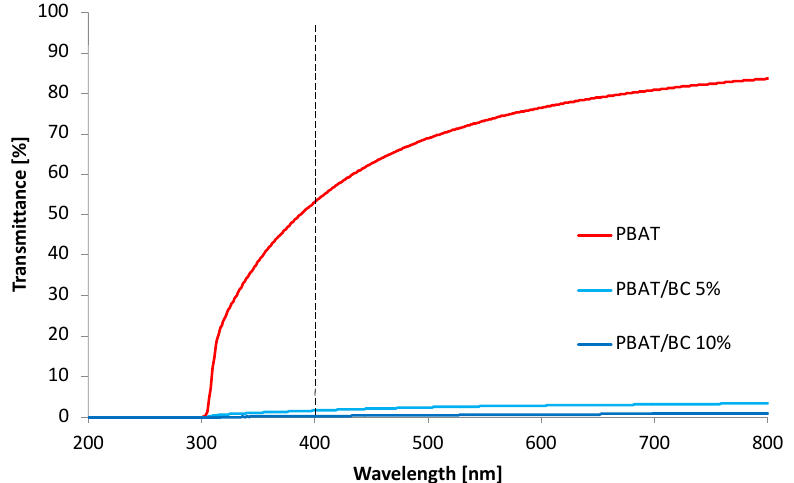
Figure 9. UV-Vis spectra of PBAT-based blown film.